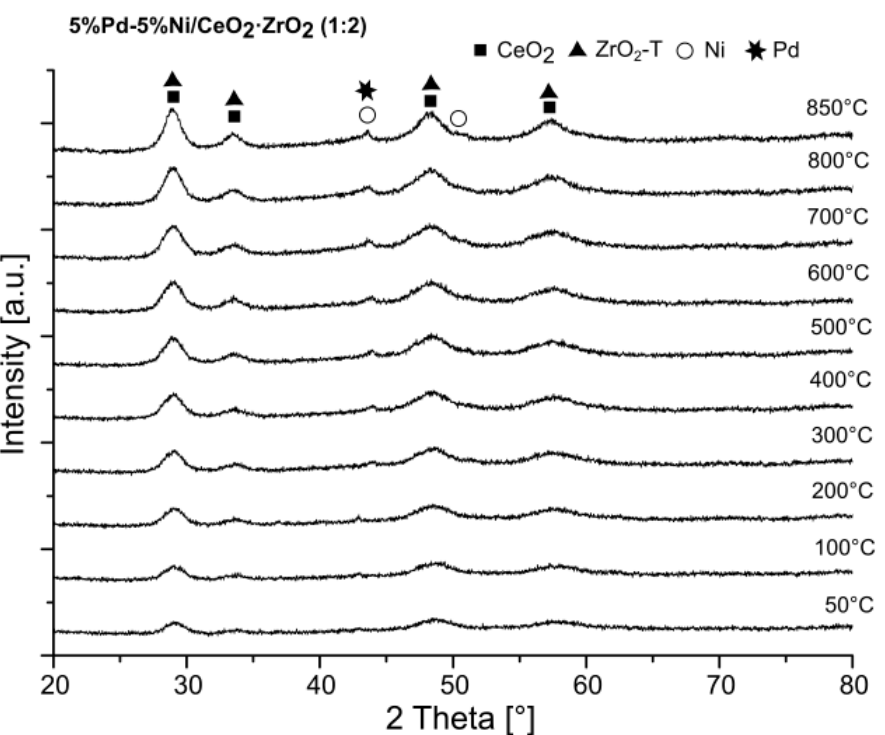
Figure 4. The X ‐ ray diffraction measurements recorded for 5%Pd ‐ 5%Ni/CeO 2 ∙ ZrO 2 (1:2) catalyst Figure 4. The X-ray diffraction measurements recorded for 5%Pd-5%Ni/CeO 2 · ZrO 2 (1:2) catalyst performed the in situ reduction process. performed the in situ reduction process.